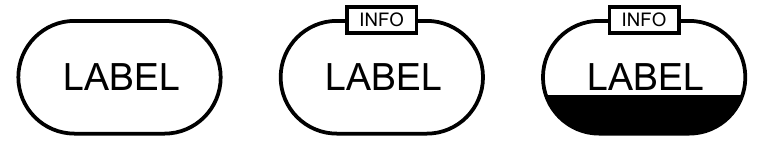
Figure 2.11: The Process Description glyph for a simple chemical , shown plain and un- adorned on the left, with an additional unit of information in the middle, and with a simple clone marker on the